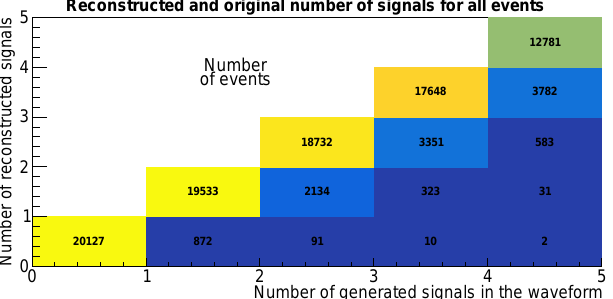
Figure 6. Number of reconstructed signals versus the original number of generated signals in the test sample.